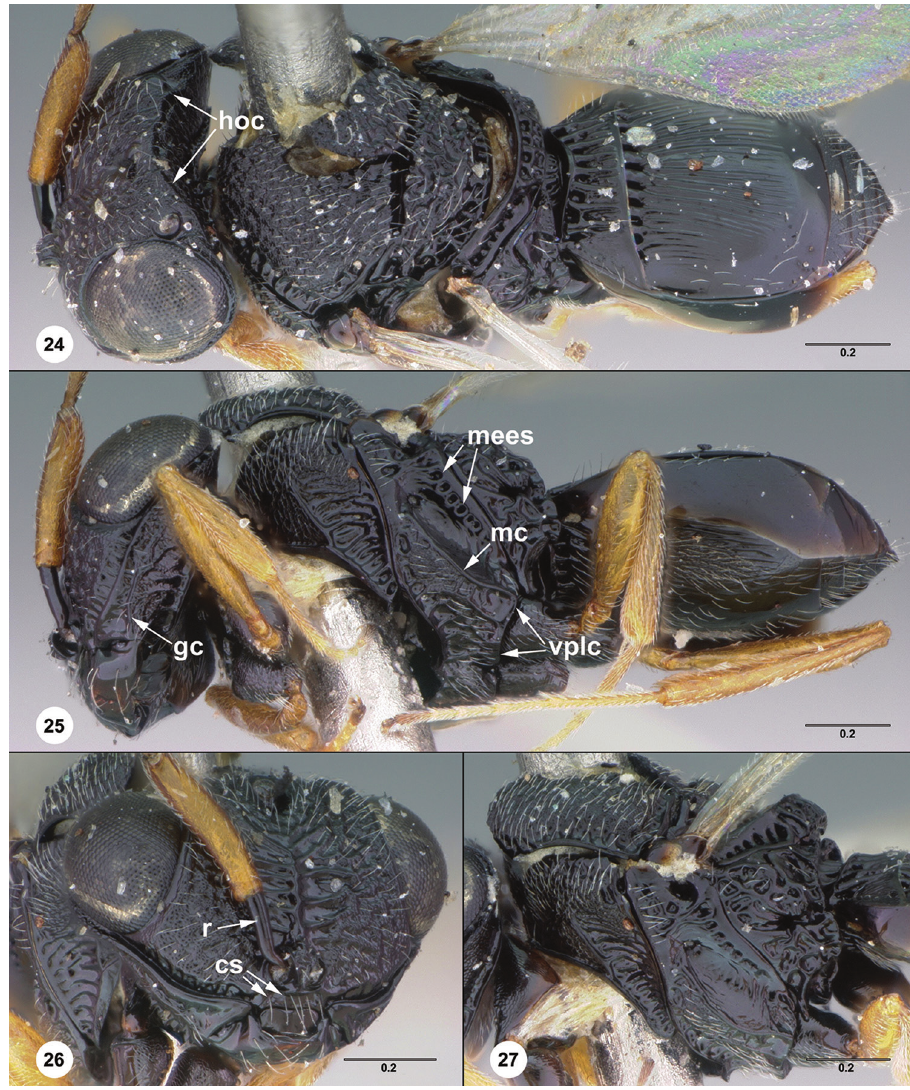
Figures 24–27. T. carinifrons , female holotype (B.M. TYPE HYM. 9.312) 24 head, mesosoma, metasoma, dorsolateral view 25 head, mesosoma, metasoma, ventrolateral view 26 head, anterior view 27 mesosoma, lateral view. Scale bars in